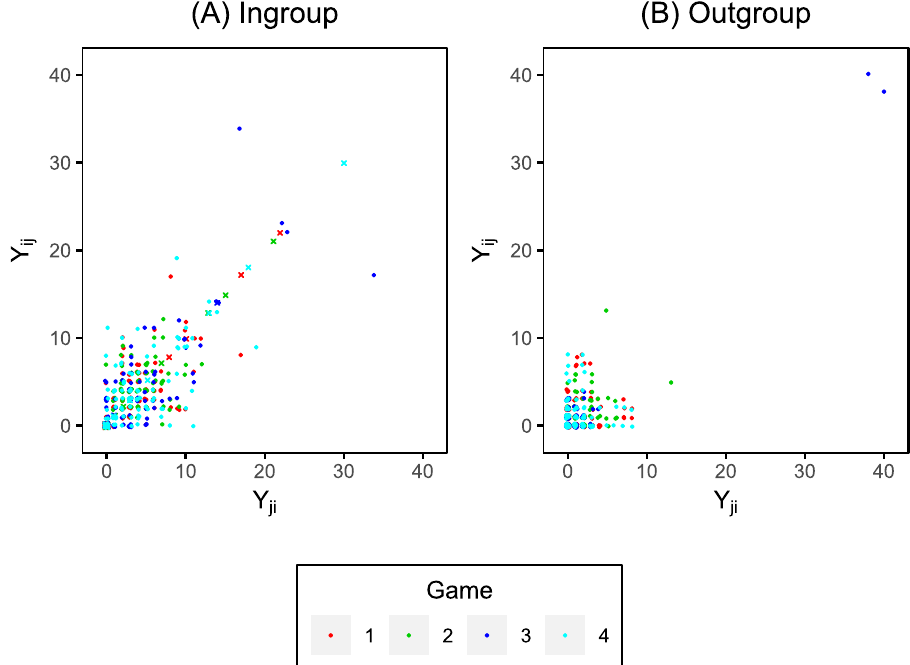
Figure 5. The number of tokens received is plotted against the number of tokens given for ( A ) players in the same group and ( B ) players in different groups. The × symbol indicates self-giving. The points at (38, 40) and (40, 38) in plot ( B ) correspond to two players who reciprocated for almost the entirety of the game.